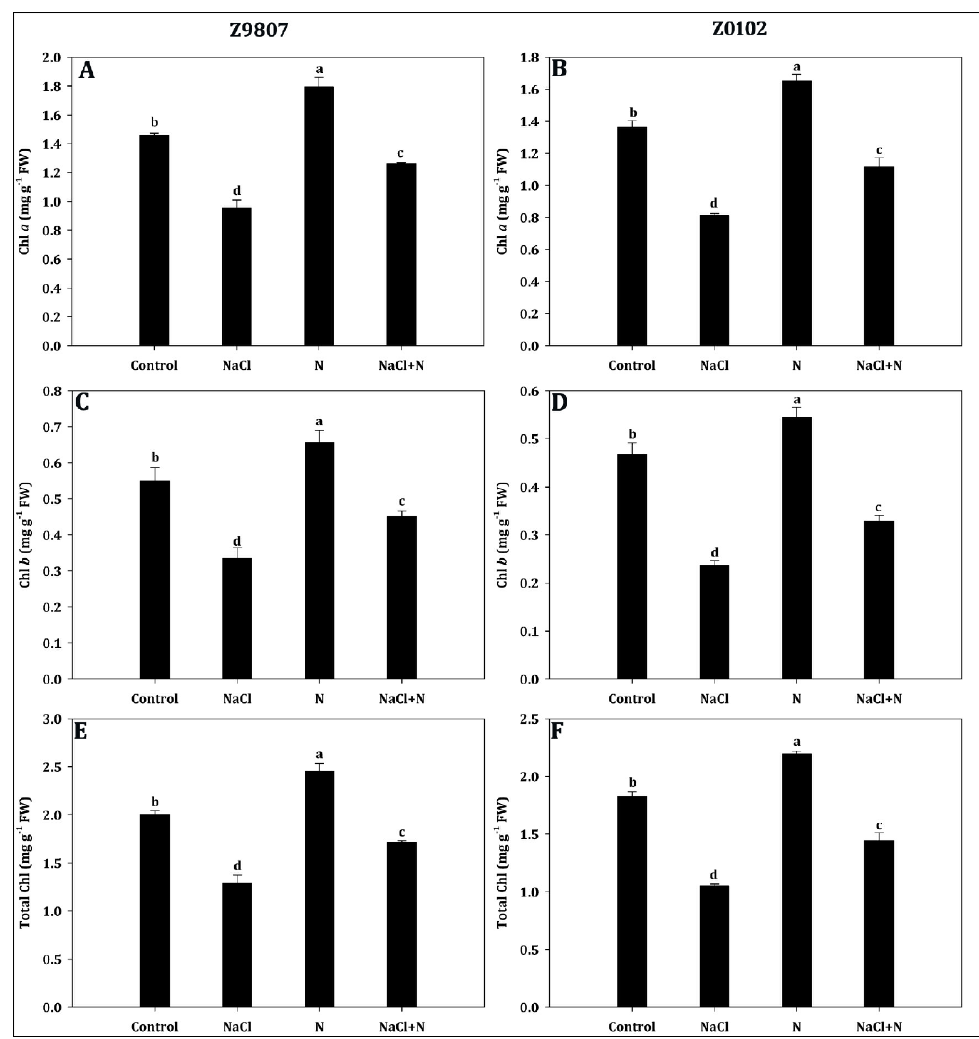
Figure 3. Effect of nitrogen supplementation on ( A , B ) chlorophyll a , ( C , D ) chlorophyll b , and ( E , F ) total chlorophyll content in Gossypium hirsutum L. under salinity stress. Data represent the mean of three replicates and bars with different letters denote significant differences at p < 0.05.